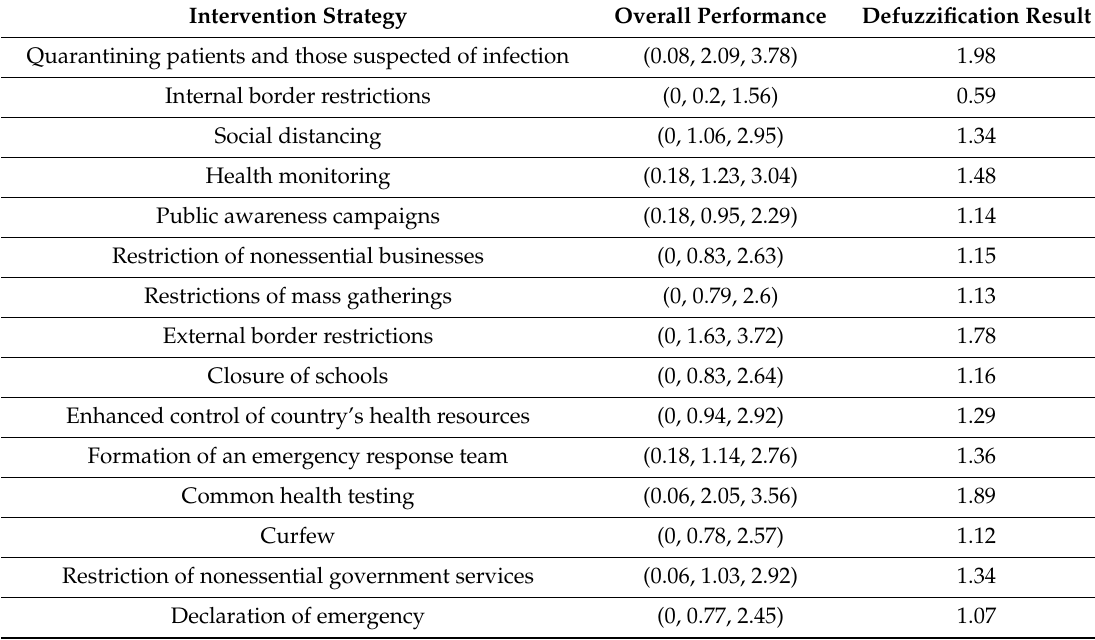
Table 8. The assessment results.